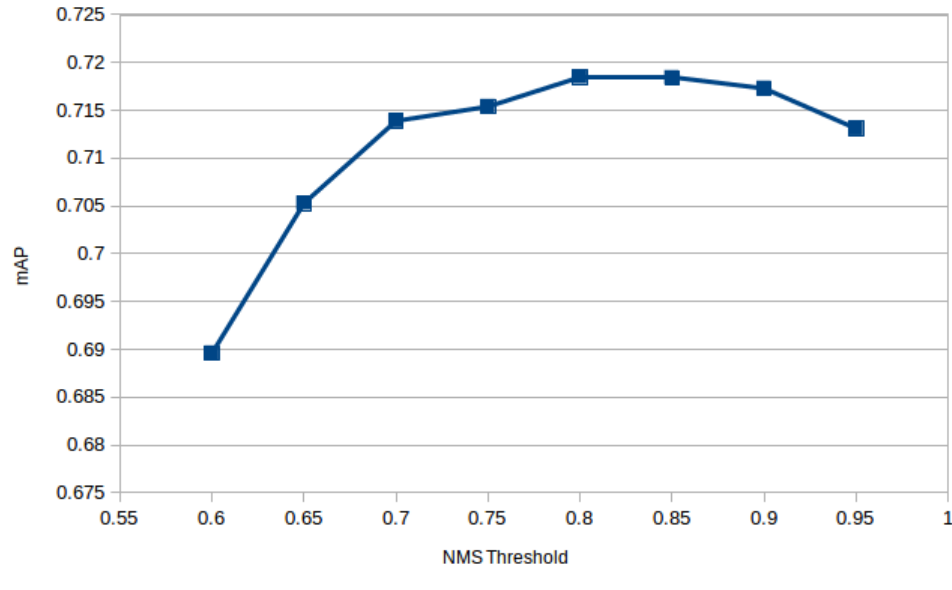
Figure 10. Mean average precision (mAP) values for different non-maximum suppression (NMS)